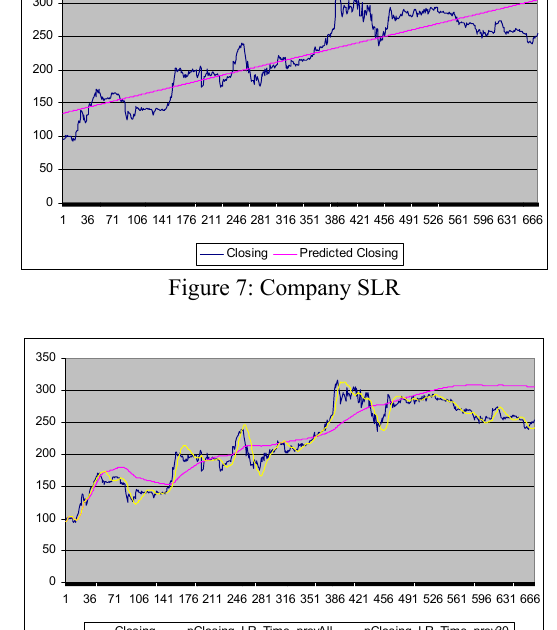
Figure 8: Company LR